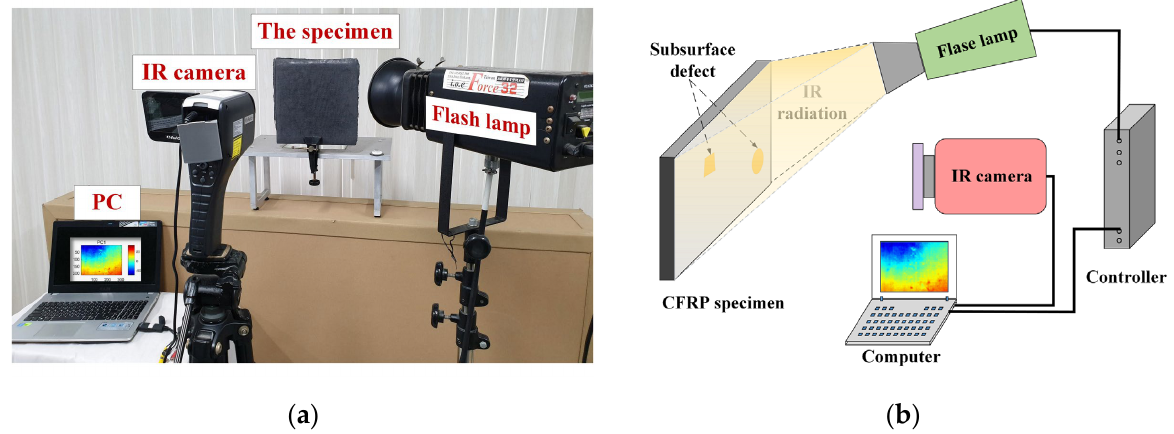
Figure 1. Flash thermographic NDT configurations: ( a ) experimental set-up; ( b ) schematic set-up. The operation process of each component of the IRT system is described briefly.